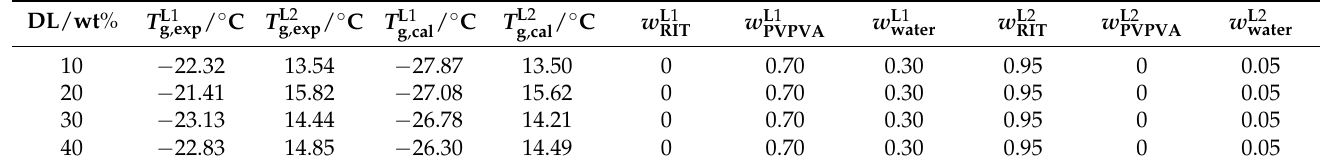
Figure 2. Ternary phase diagram of RIT/PVPVA/water at 25 ◦ C and 0.1 MPa illustrating the PC-SAFT predicted miscibility gap (gray solid line enclosing the gray area), including tie lines (gray dash-dotted lines). Compositions are given in mass fractions. The green dotted line is the glass transition calculated using the Kwei equation. The glassy region is denoted as a green area. Symbols denote measured water-sorption data at 23% RH (squares), 53% RH (circles), 94% RH (triangles upwards), and 97% RH (triangles to the right) for the single-phase (blue symbols) and demixed systems (white symbols). Gray triangles represent the experimentally determined equilibrium compositions after amorphous phase separation at 94% RH, as summarized in Table 6. Table 6. Glass-transition temperatures and compositions of RIT/PVPVA ASDs stored at 94%